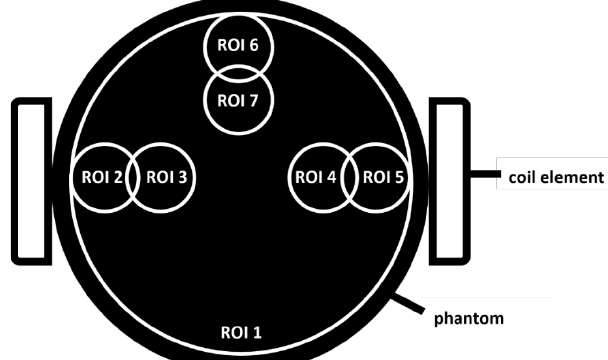
Figure 2. Cylindrical phantom filled with 18 F-FDG. Seven circular ROIs were drawn. ROIs 2 – 7 were 2 cm in diameter and positioned 2 and 3.5 cm from the outer edge of the phantom. ROI 1 was 12 cm in diameter and was drawn 1 cm from the outer edge of the phantom and encompasses all other ROIs. All ROIs were extended to slices along the entire length of the phantom. The mean radioactivity concentration (Bq/mL) was calculated for each ROI. This value was then normalized to the mean no surface coil activity in ROI